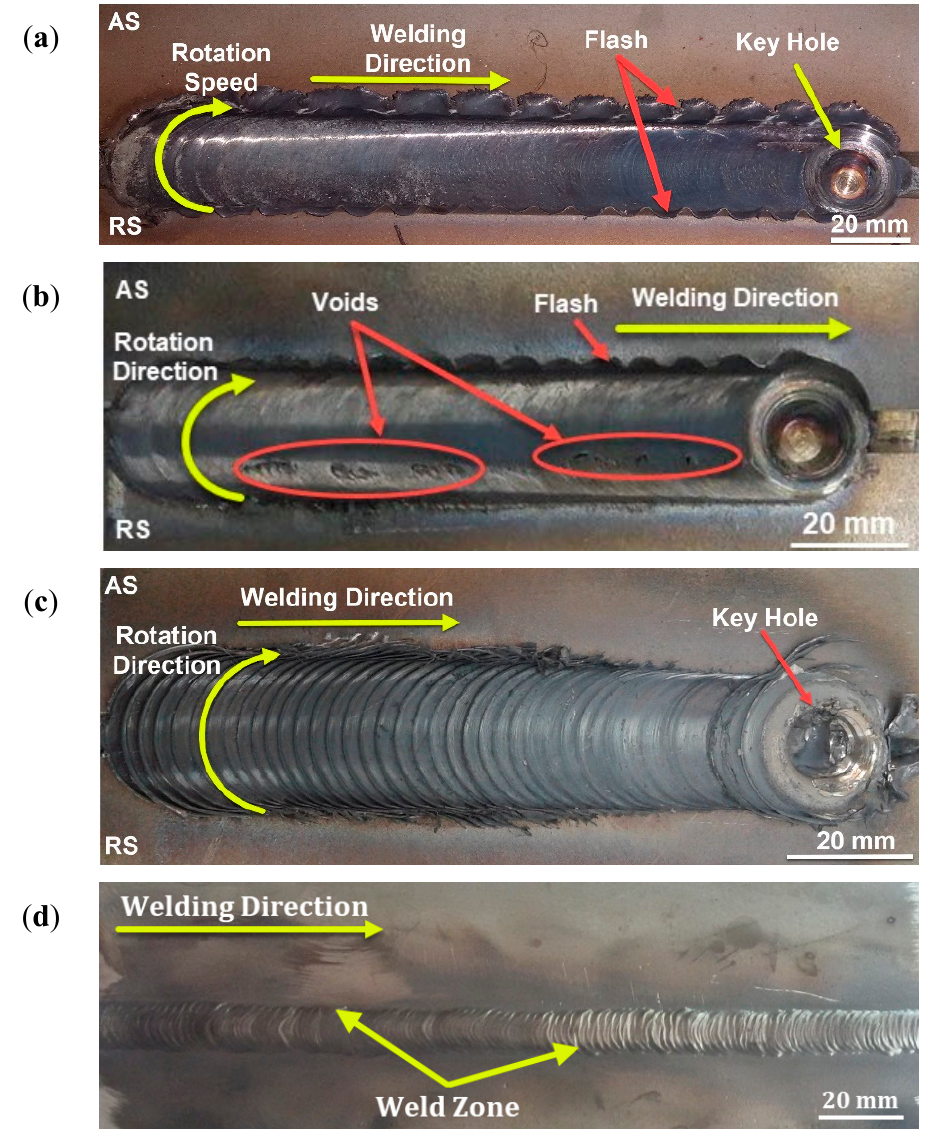
Figure 6. Top view of FSW welds ( a ) FSW, U-shaped groove with root; ( b ) FSW, V-shaped groove without root; ( c ) FSW, V-shaped groove with root face; and ( d ) GTAW, V-shape groove with root face and gap GTAW weld for 2205 DSS butt joints [33].